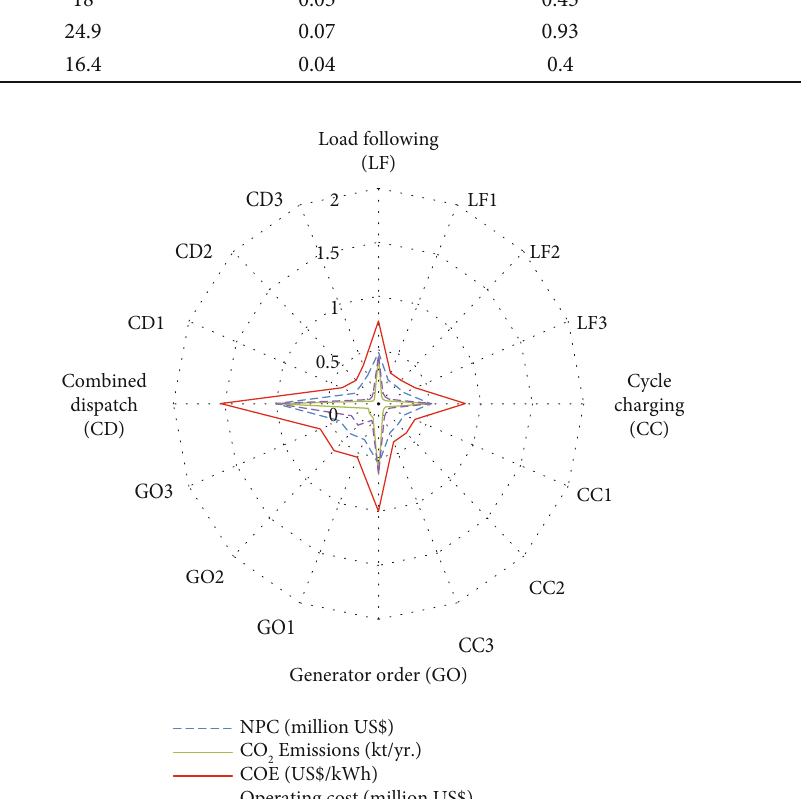
Figure 7: The di ff erence in various parameters for three cases for four strategies. This fi gure is reproduced from Shezan et al.